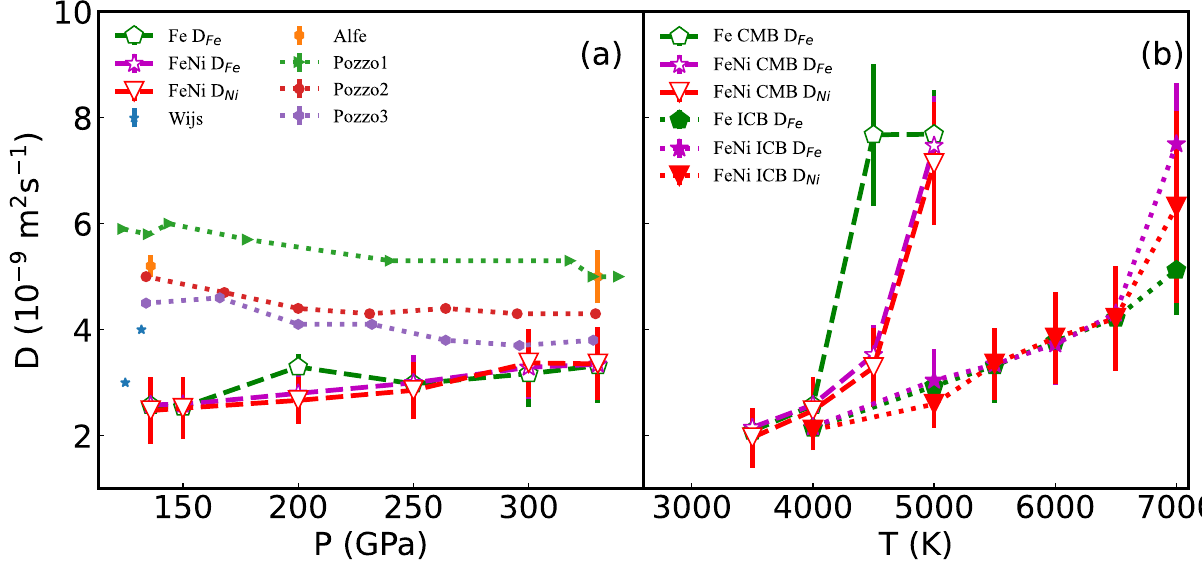
Figure 3. The self-diffusion coefficients ( D Fe and D Ni ) of Fe and FeNi fluid under Earth’s core conditions. ( a ) is along the core adiabatic, and ( b ) is temperature variation at CMB and ICB. ‘Wijs’ 18 , ‘Alfe’ 8 , ‘Pozzo1 ′ 9 , ‘Pozzo2 ′ 9 and ‘Pozzo3 ′ 9 represent the self-diffusion coefficient of Fe in Fe, Fe 0.82 Si 0.10 O 0.08 and Fe 0.79 Si 0.08 O 0.13 fluids.